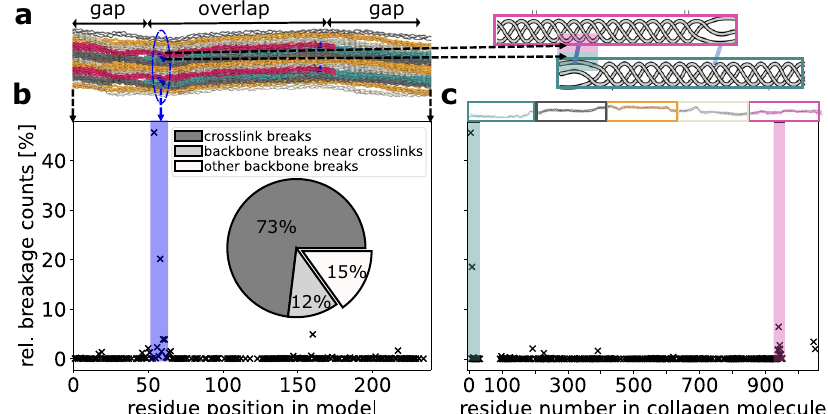
Fig. 3 | Collagen ruptures primarily in crosslinks, but also unspeci fi c ruptures occur everywhere. Data were obtained from 63 independent MD simulations, includingdivalentandtrivalentcrosslinksetups,withdifferentcollagensequences and pulling conditions, as described in the methods section. For simulations with trivalent crosslinks, we used the deprotonated BDEs of PYD. In both panels b and c the same data is presented in two different reference systems. a Left side: Locationofresiduesandcrosslinksinourmodelalongthe fi beraxis.Triplehelices with the same phase are in the same color,respectively. Upper and lower residues participating in the same crosslinks (blue) appear in the same residue position in the model; see, for example, the blue encircled area. This view is used in panel b . Right side: Crosslinks along a whole 300nm collagen molecule occur at the fragmentsoftheweakC δ -C ϵ bondofHLKNLhavelargeRSEsof − 68and − 70 kJmol − 1 (literature: − 65.3kJmol − 1 25 ). Furthermore, cleavage of the second weakest bond in HLKNL, C ϵ -N ζ , forms radicals stabilized cap- todatively by a carbonyl group in the beta position, as well as an N-centered radical with a moderate RSE of -30 kJ mol − 1 (literature: − 25kJmol − 1 5 ).